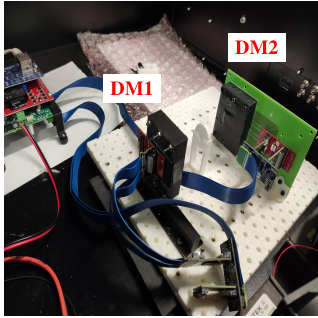
Fig. 3: Probe calibration setup. Detector modules 1 (DM1) and 2 (DM2) are composed of a SiPM (S14161-3050HS-08, Hamamatsu) and a monolithic CeBr 3 crystals.